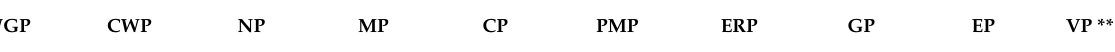
Table 2. Congruence tests among the sequence and subcellular protein-content-based trees